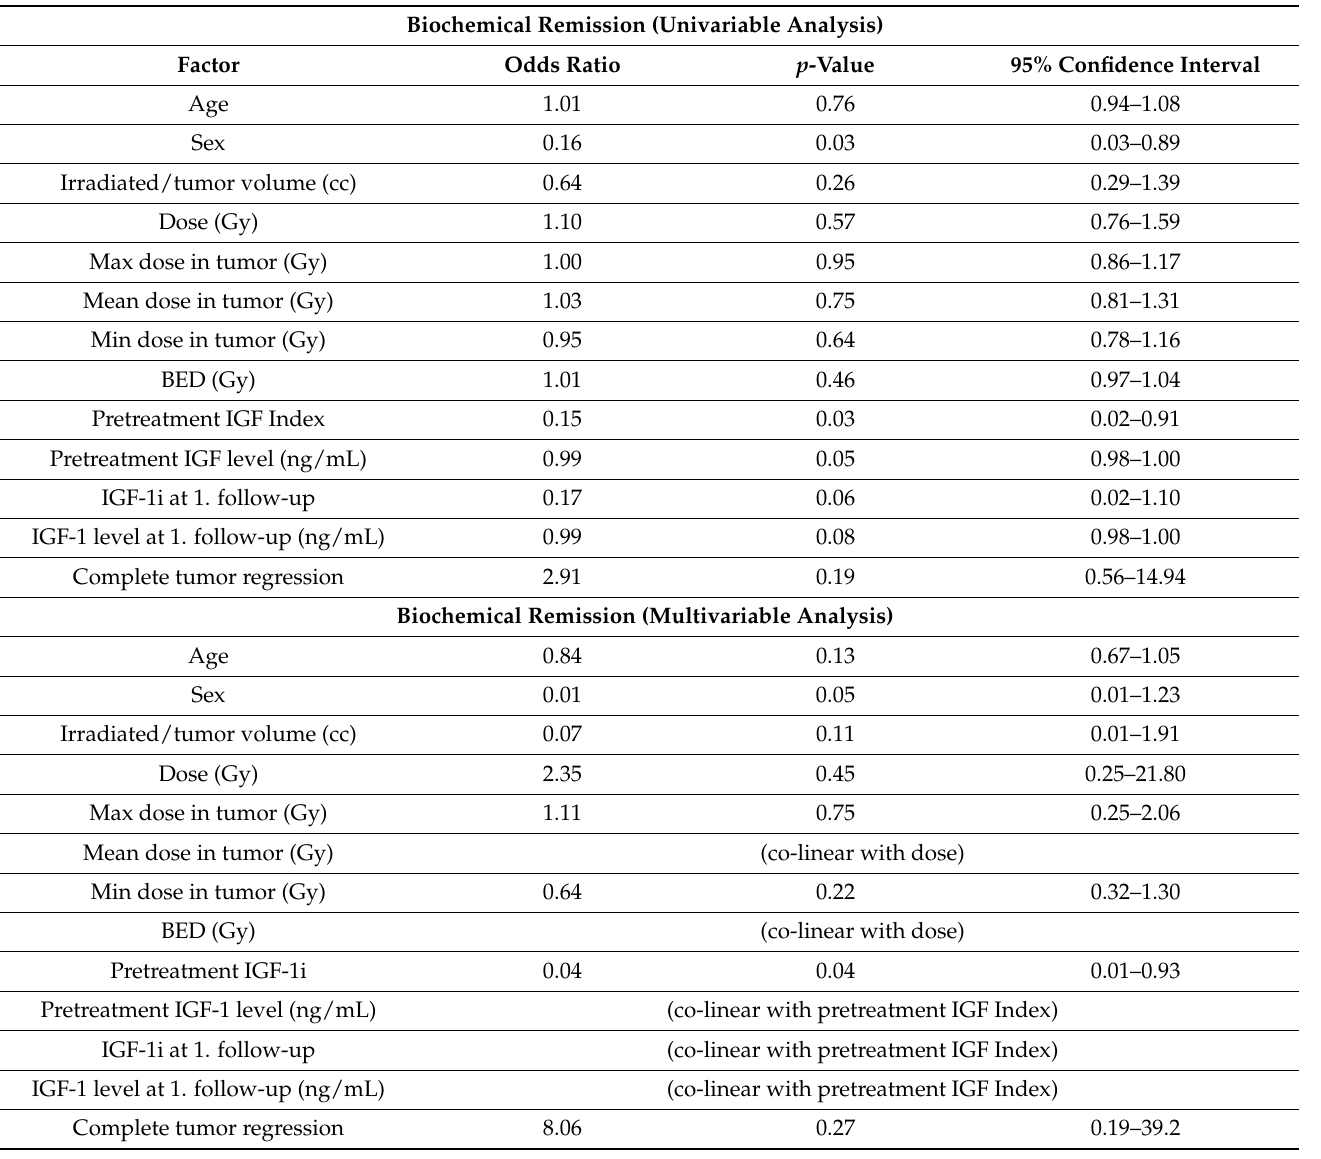
Table 4. Logistic regression analyses for patients with biochemical remission at last